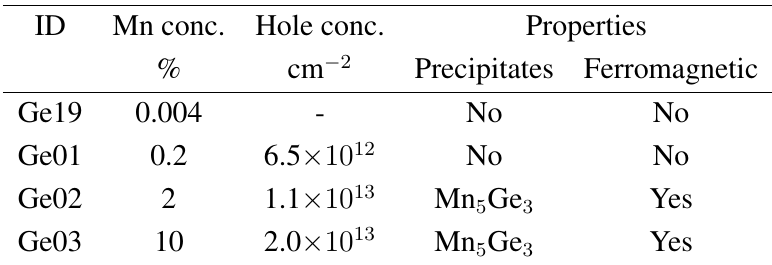
Table 1 . Sample identification (ID), Mn concentration (Mn conc.), sheet hole concentration (Hole conc.) and magnetic properties. (Reprinted with permission from Ref. [55]. Copyright 2009, American Institute of